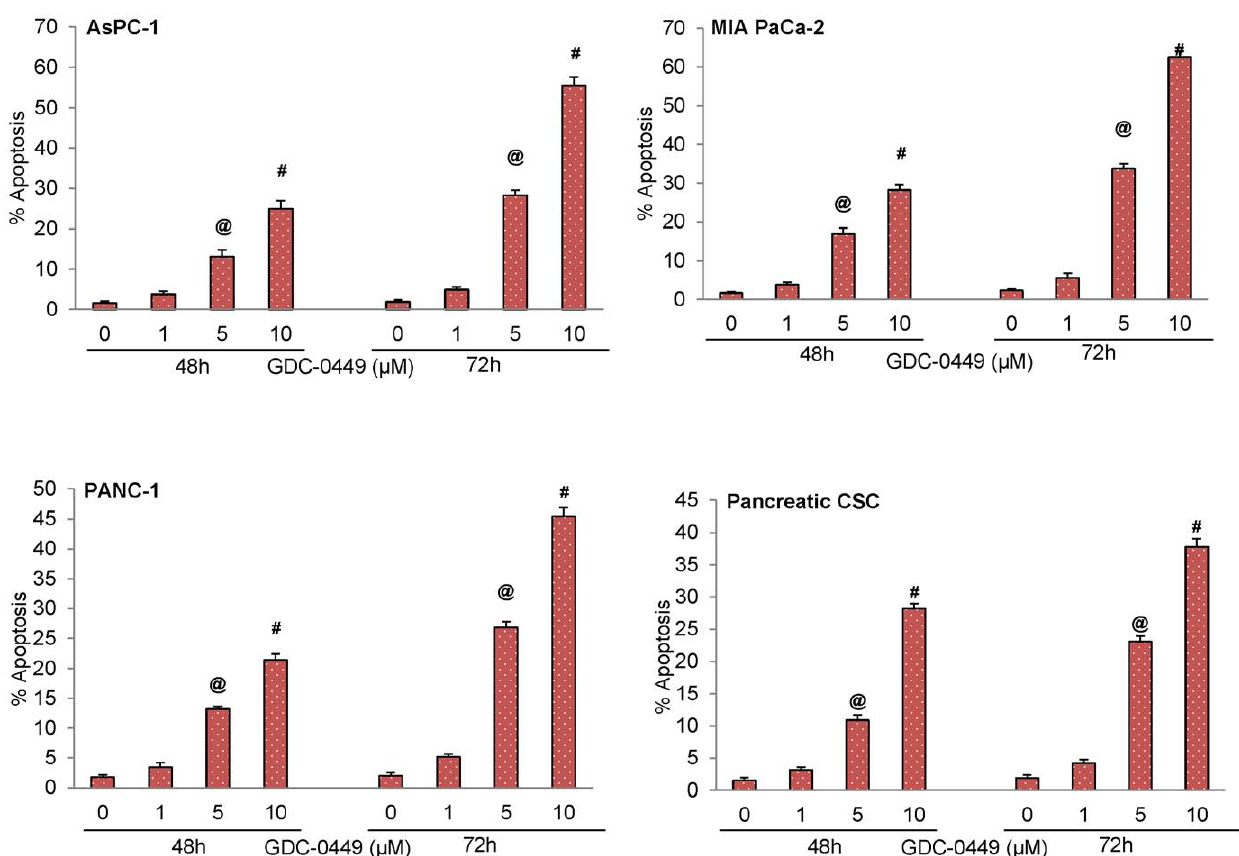
Figure 3. Induction of apoptosis by GDC-0449 in pancreatic cancer cell lines and pancreatic CSCs. The cells were treated with GDC-0449 (0, 1, 5 and 10 m M) for 48 and 72 h. At the end of incubation period, cells were harvested and apoptosis was measured. Data represent mean 6 SD. @ or # significantly different from respective control (P , 0.05).